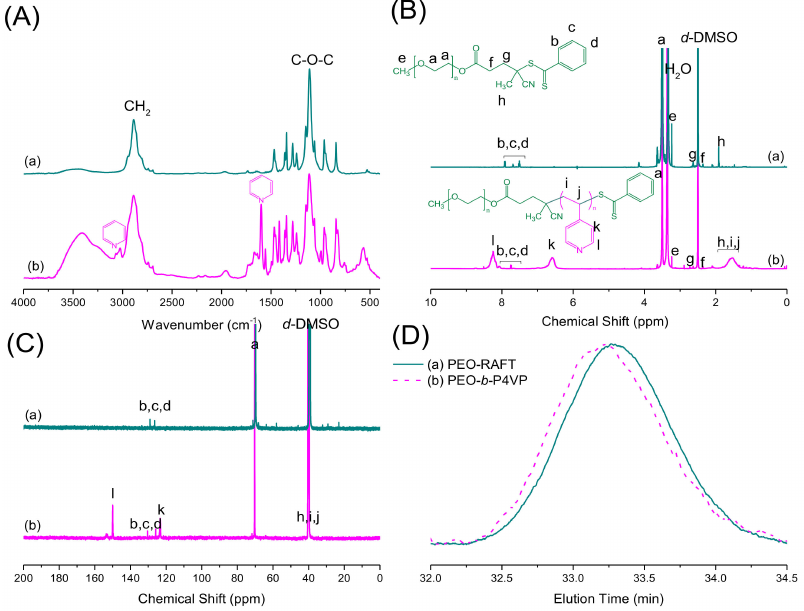
Figure 2. ( A ) FTIR, ( B ) 1 H, ( C ) 13 C-NMR, and ( D ) GPC analyses of (a) PEO-RAFT and (b) PEO- b